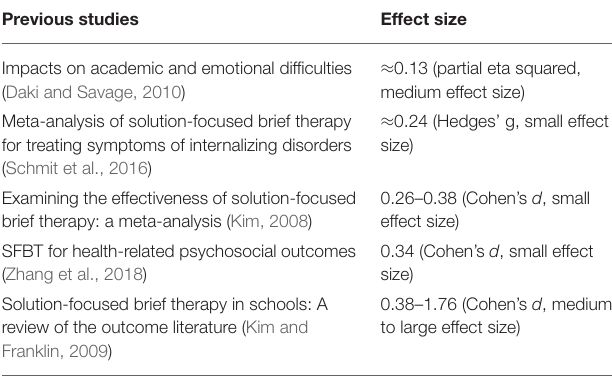
TABLE 1 | The effect size from the solution-focused brief therapy (SFBT)-related studies. Previous studies Effect